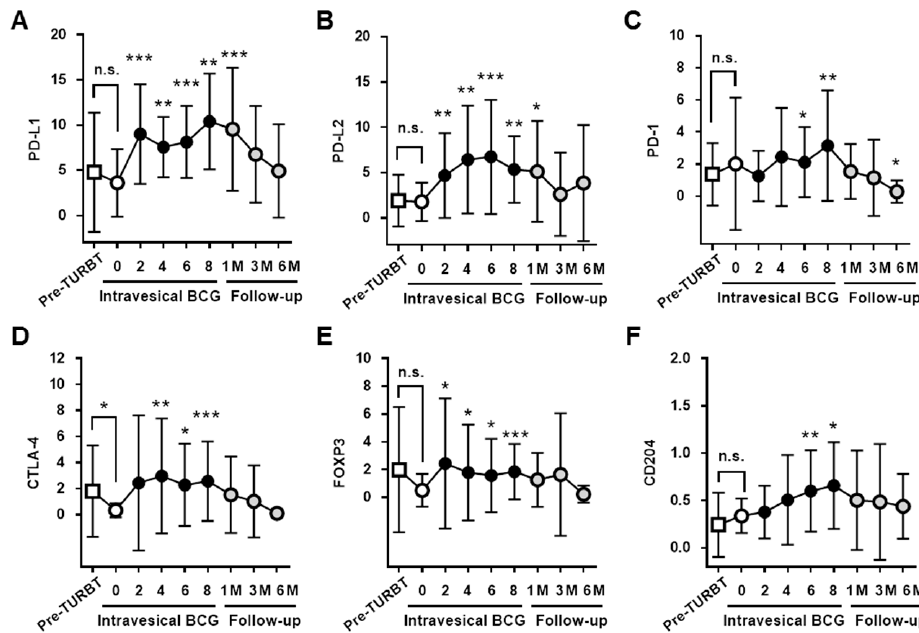
Figure 2. Time-course changes in mRNA expression of four immune checkpoint proteins, reguratory T cell (Treg) marker, and tumor-associated macrophage (TAM) marker in voided urine sediment from NMIBC patients before, during, and after the treatment. The expression levels of PD-L1 ( A ), PD-L2 ( B ), PD-1 ( C ), CTLA-4 ( D ), FOXP3 ( E ), and CD204 ( F ) in voided urine sediment. The value at each treatment time point is the mean ± SD and compared with those at the pre-BCG baseline (indicated by ‘0’) using the Wilcoxon signed-rank test. Changes in other parameters are shown in supplementary Figures S1–S5. * p < 0.05, ** p < 0.01, *** p < 0.001.